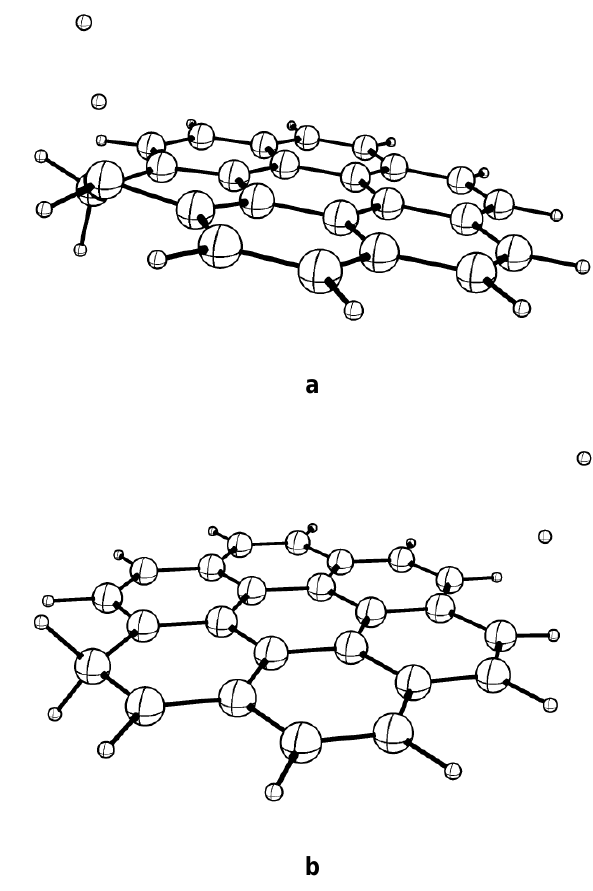
Fig. 6. Hydrogenation by H2 when attacking a neighboring atom (a) and the opposite edge of the cluster (b) Table 2. The bond lengths characterizing transition states (in